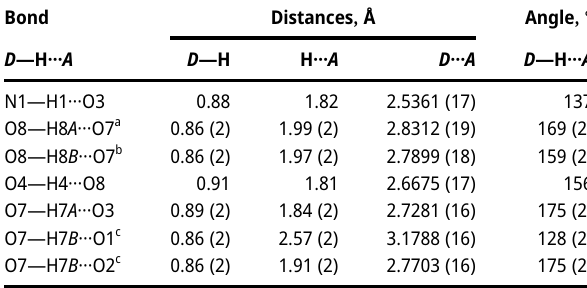
Table  : Fractional atomic coordinates and isotropic or equivalent isotropic displacement parameters (Å  ).